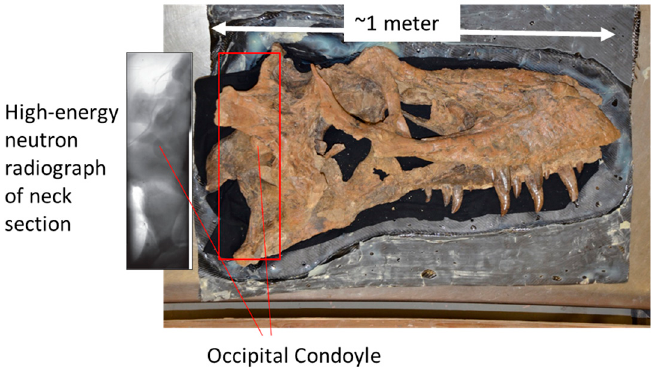
Figure 18. Photo of the 74.5 million year old skull of the tyrannosauroid dinosaur Bistahieversor sealeyi collected from northwestern New Mexico. A high-energy neutron radiograph taken in 4 sections of the left most portion of the skull is shown at far left. The fossil was also imaged with 6-MeV (Bremsstrahlung) X-rays at the Los Alamos Microtron facility. Good definition is seen in the images which may provide complimentary information to the X-ray images. Combining the multiple neutron images and reconstructing the CT scan is in progress.